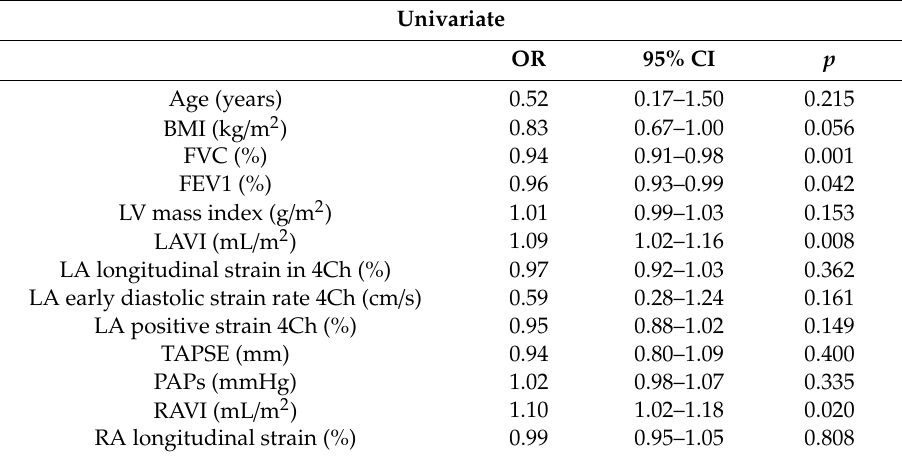
Table 5. Predictors of mortality in patients with cystic